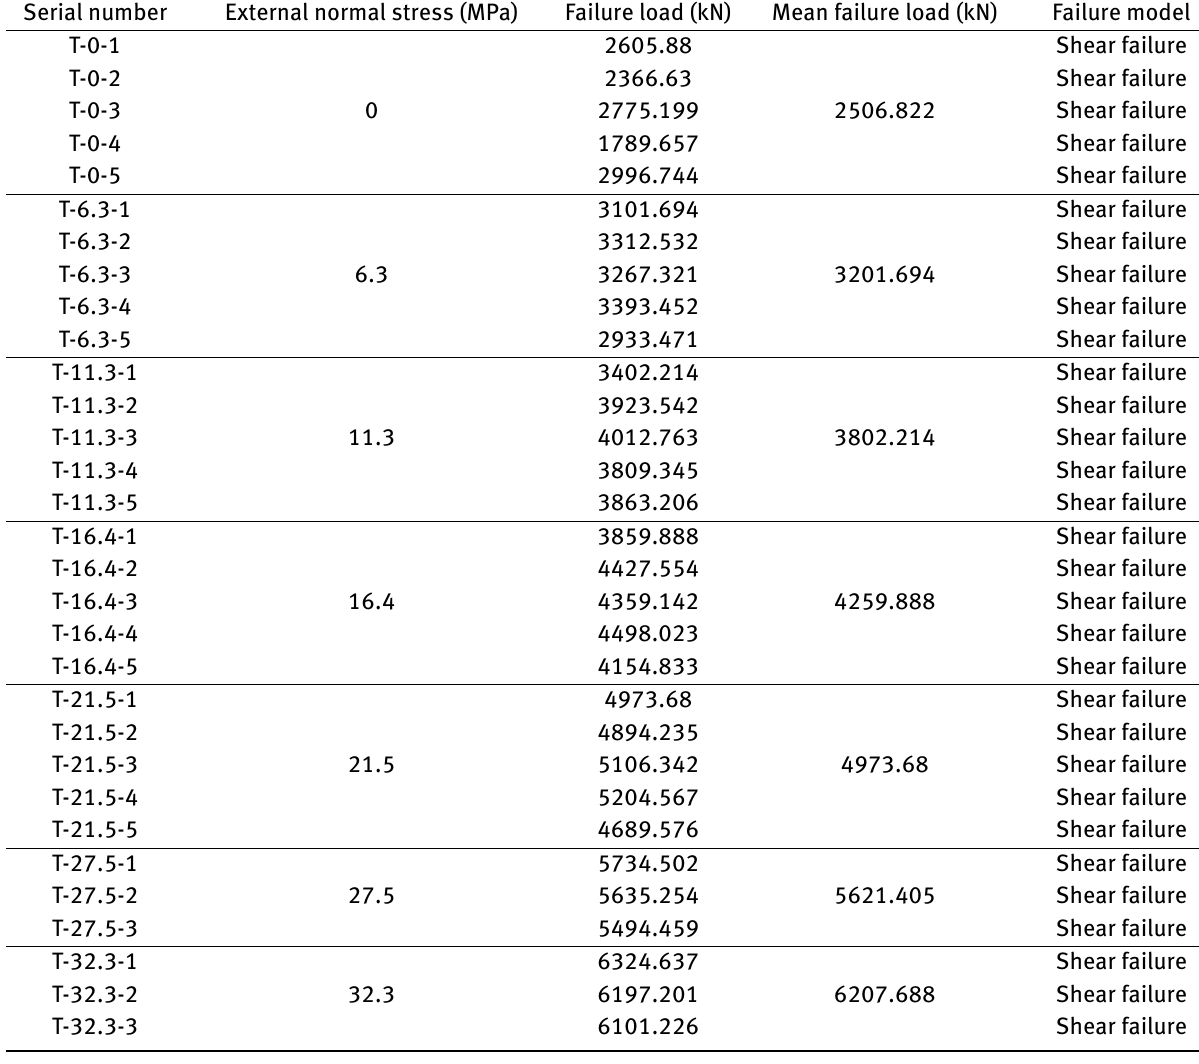
Table 2: The result of experiment